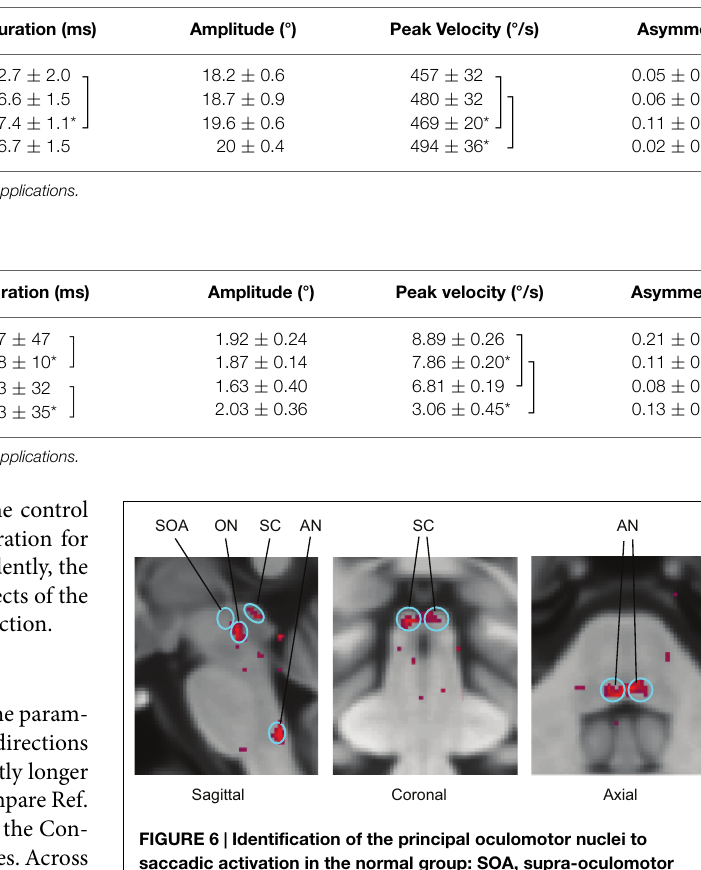
TABLE 2 | Oculomotor dynamics for horizontal saccades .